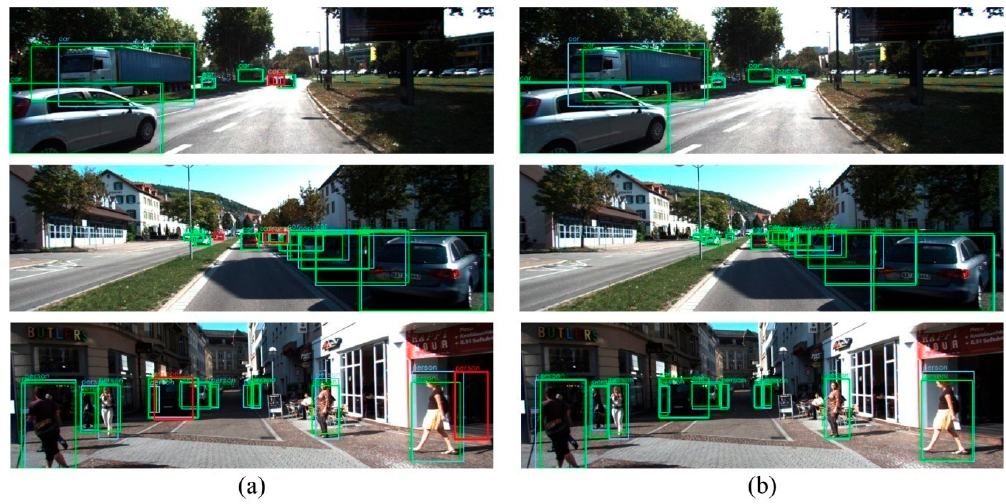
Figure 9. Comparison of each network on the KITTI dataset. ( a ) YOLO V3; ( b ) Improved YOLO V3.